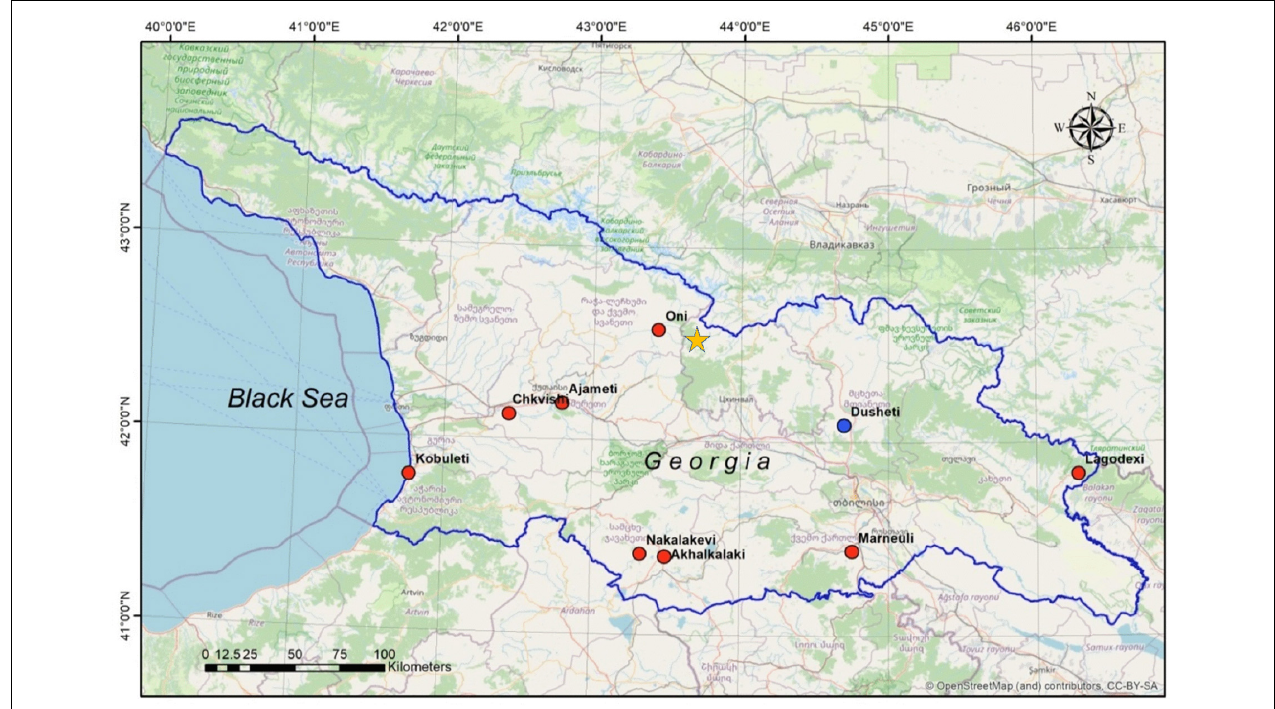
FIGURE 2 | Map of Georgia with location of the deep wells’ network (red circles) for WL monitoring and the Dusheti Geomagnetic Observatory (blue circle). The star marks the location of the 1991 M7 Racha EQ.